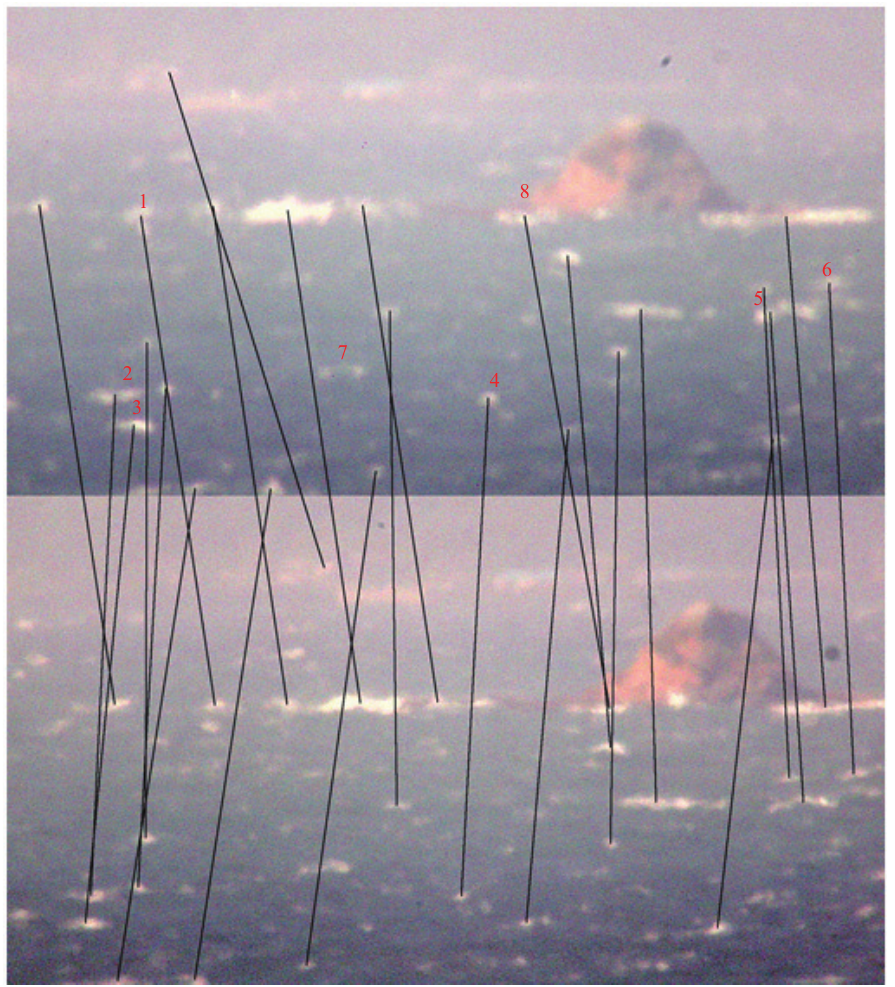
Figure 11. Matching result of the decision tree